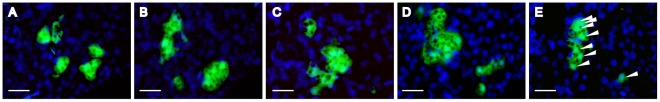
Serial paraffin sections of YFP-positive cell cluster in the liver.A cluster of YFP-expressing cells (green) was identified in five consecutive liver sections (A–E) by immunofluorescence with anti-GFP antibody, demonstrating its 3D structure. DAPI staining (blue) indicates cells nuclei. Arrowheads in E indicate nuclei of transduced cells. Scale bar = 20 µm.